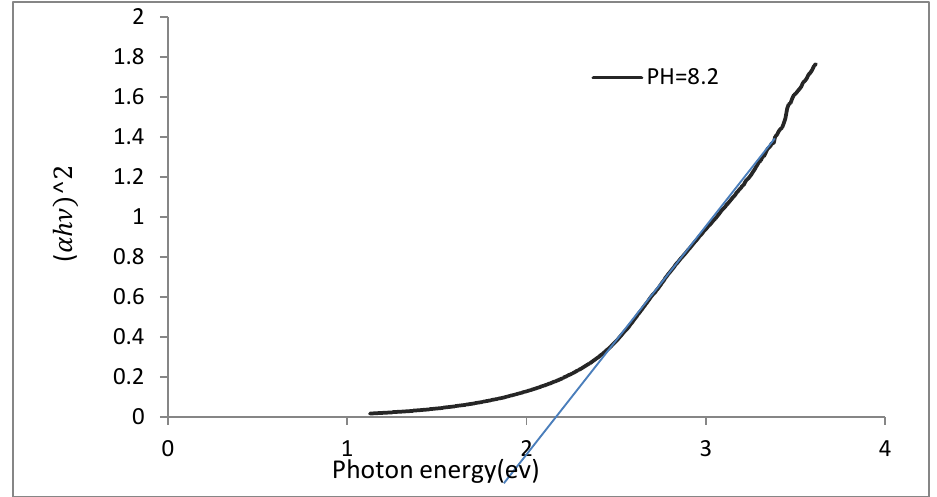
Figure (6): The optical energy gap CdO thin-film pH =8.2